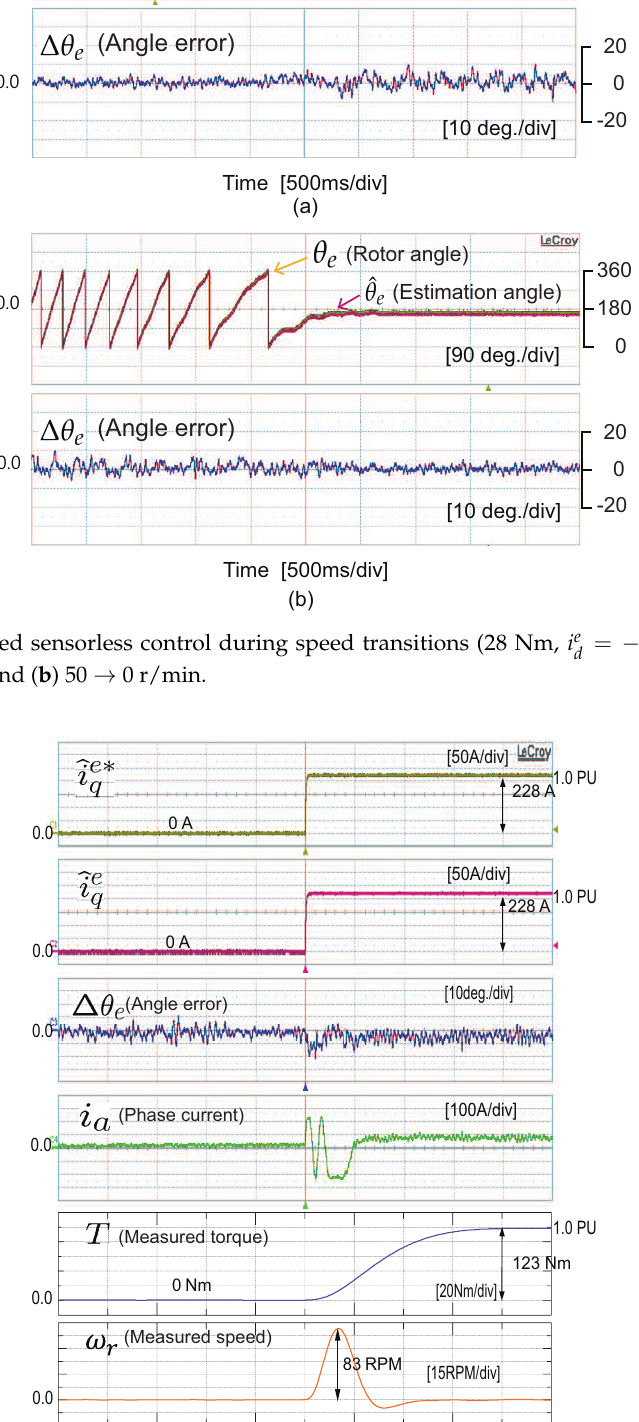
Figure 15. Current responses at a standstill for a q -axis command (0 A → 228 A) when i e q -axis current command, q -axis current, angle error, phase current, shaft torque, and shaft